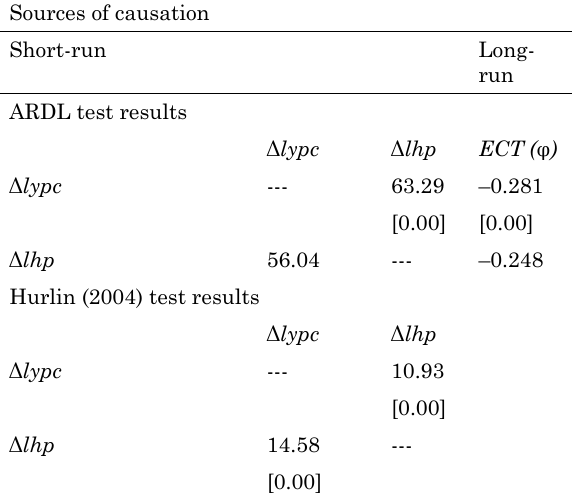
Table 5. Causality test results Sources of